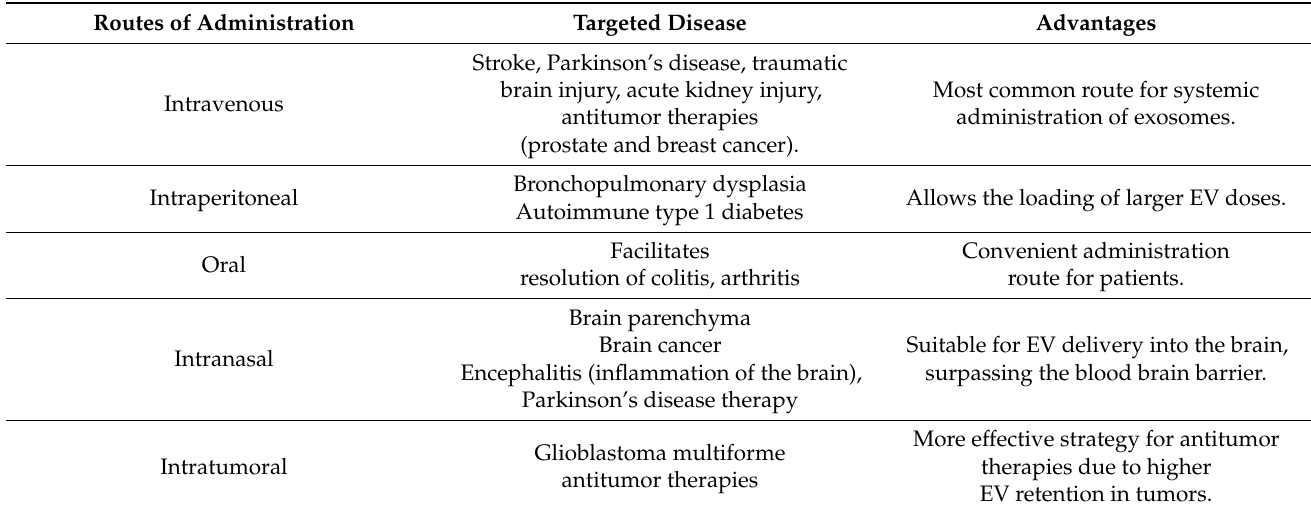
Table 4. Advantages and targeted diseases of exosomes administered via different routes [145,164–168]. Routes of Administration Targeted Disease Advantages Stroke, Parkinson’s disease, traumatic brain injury, acute kidney injury, Intravenous antitumor therapies (prostate and breast cancer).